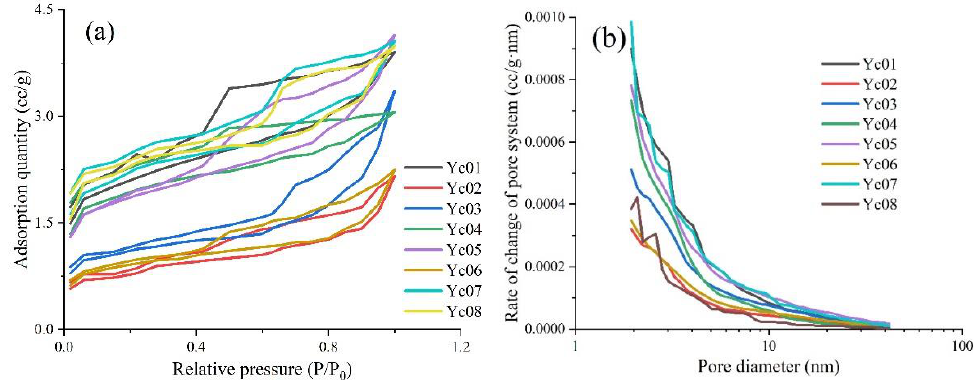
Figure 3. Plots illustrating ( a ) the low pressure N2 adsorption–desorption responses of the shales studied and ( b ) the pore size distribution of the samples.